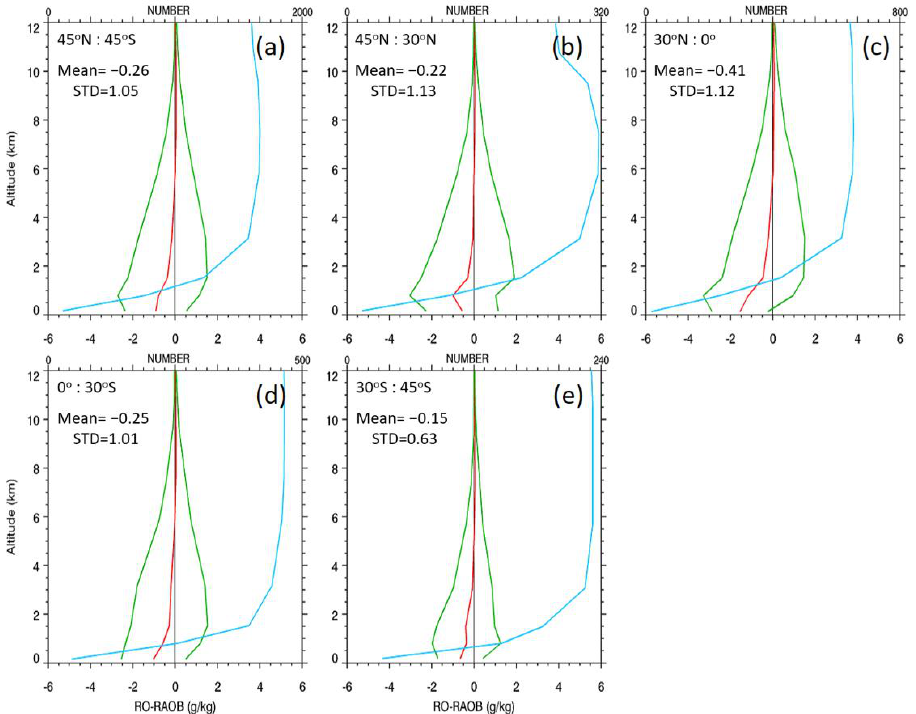
Figure 9. The mean difference (red lines) +/ − standard deviation (green lines) for (STAR-RAOB) profiles of specific humidity for October 2019 for ( a ) the 45 ◦ N–45 ◦ S, ( b ) 45 ◦ N–30 ◦ N, ( c ) 30 ◦ N to the equator, ( d ) equator to 30 ◦ S, and ( e ) 30 ◦ S to 45 ◦ S. Five panels are present, averaging in five latitude bins. RAOB type RS41 is used for comparison. The sample numbers are in the blue lines.